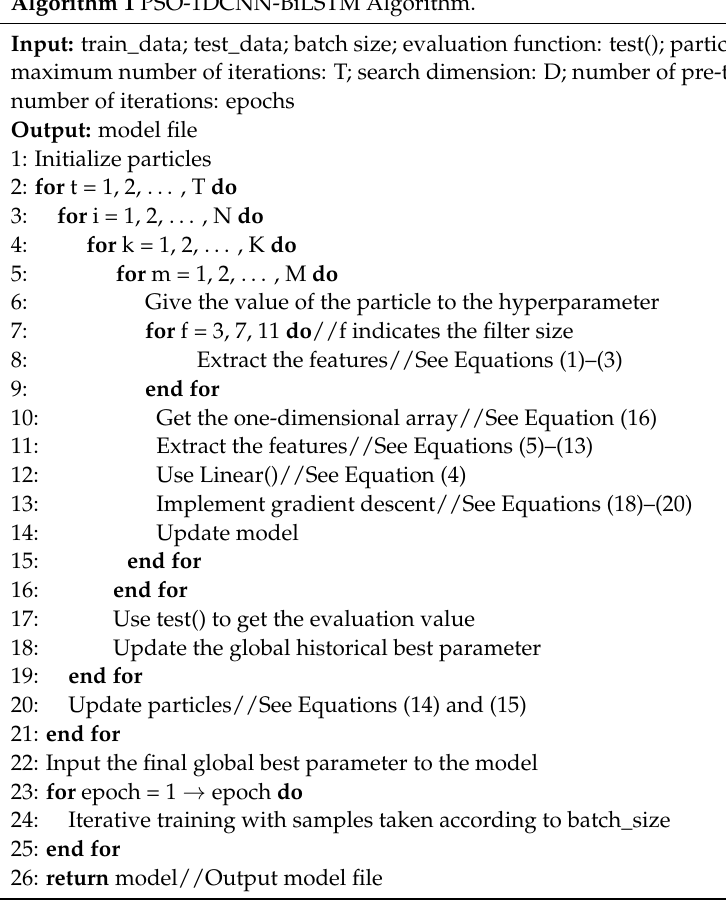
Algorithm 1 PSO-1DCNN-BiLSTM